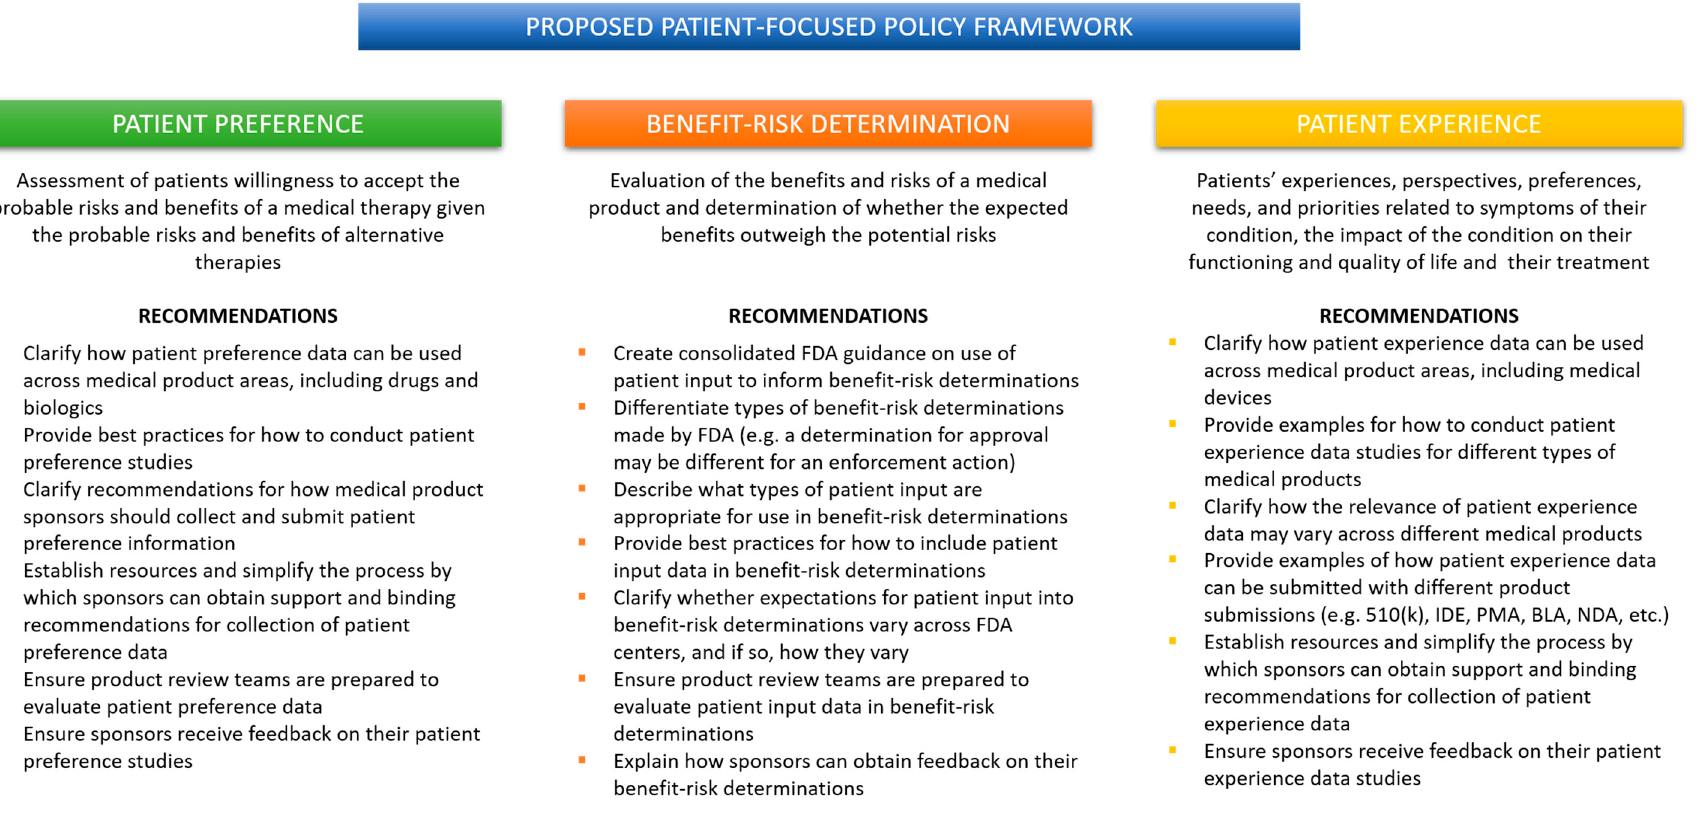
Figure 2. Proposed policy framework for FDA patient-focused policy.